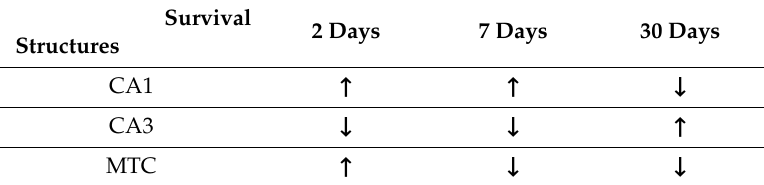
Table 3. Changes in the expression of the Alzheimer’s disease-associated presenilin 1 gene in di ff erent brain structures at di ff erent times after experimental brain ischemia. Survival 2 Days 7 Days 30 Days Structures CA1 ↑ ↑ ↓